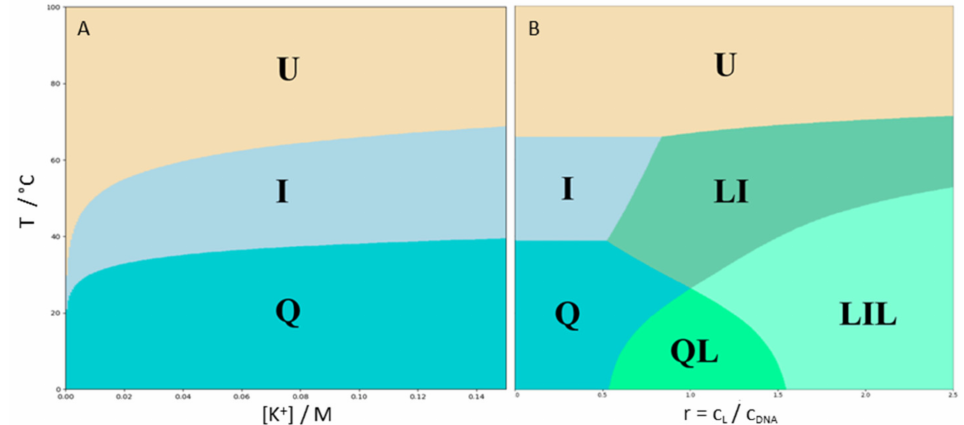
Figure 5. Phase diagrams presenting the most populated 22GT species (phases) at given T, [K + ] and ligand/DNA molar ratios, r. C L and C DNA are the total molar concentrations of the ligand (360A) and DNA (22GT), respectively. ( A ) r = 0, C DNA = 10 µ M; ( B ) [K + ] = 100 mM, C DNA = 10 µ